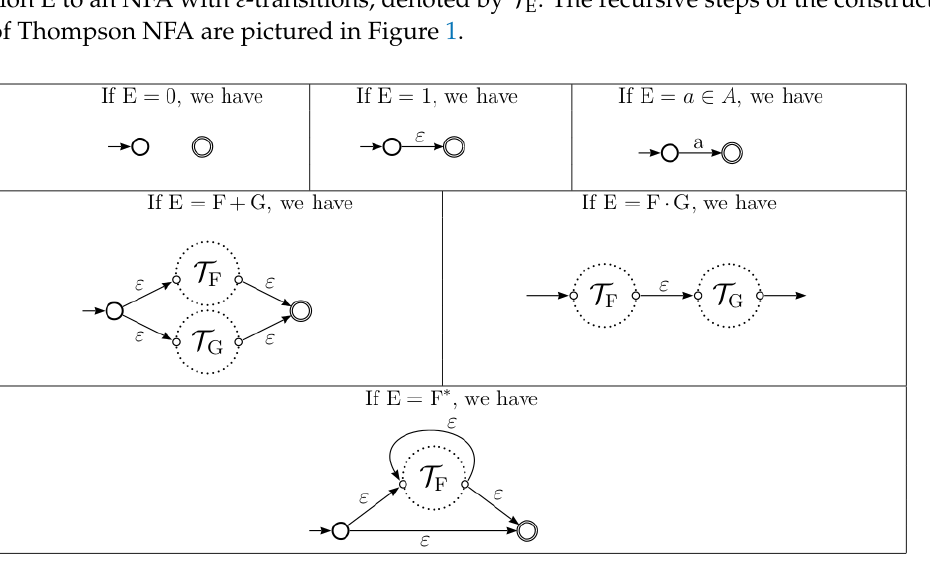
Figure 1. Thompson construction of an NFA.